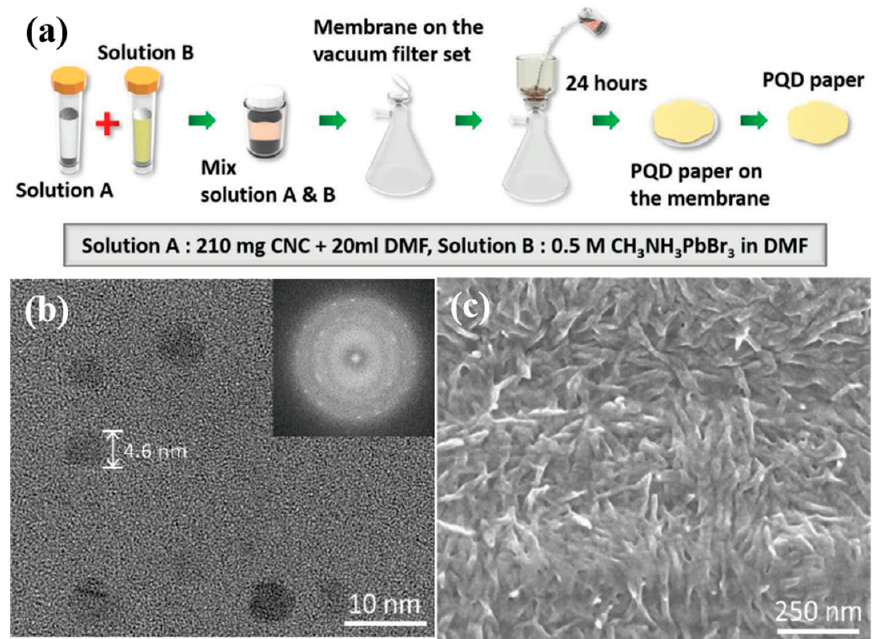
Figure 13. ( a ) Schematic of fabrication process of PQD paper. ( b ) TEM image of CH 3 NH 3 PbBr 3 PQDs. ( c ) SEM of PQD paper surface [78]. Figure reproduced with permission from John Wiley and Sons. The emission peak also corresponds to the absorption edge, and the PQDs paper can serve as a light converter for the blue GaN-LED chips, as it exhibits high absorption characteristics in the short wavelength region. In this study, the authors focused on using PQDs paper as green converter for white LED, which is achieved by placing the PQDs paper on top of the blue LED package dispensed + with a mixture of red K 2 SiF 6 : Mn 4 (KSF) phosphor and silicon resin. The PQDs paper-based